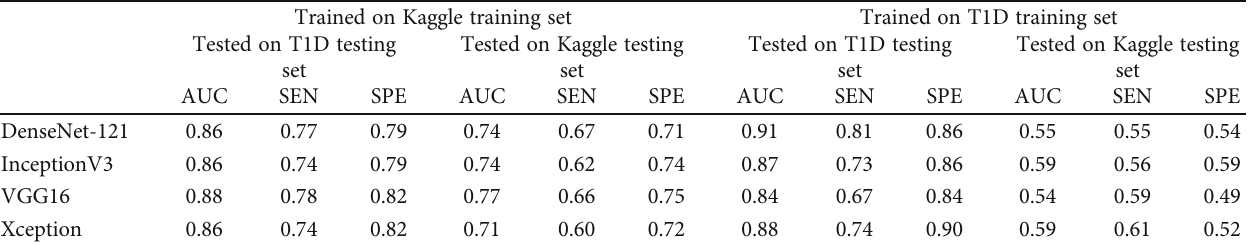
Trained on Kaggle training